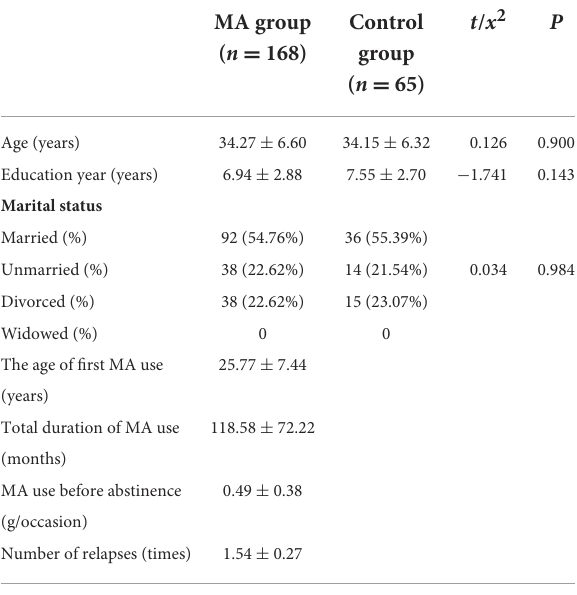
TABLE 2 Comparison of psychological characteristics between the MA group and control